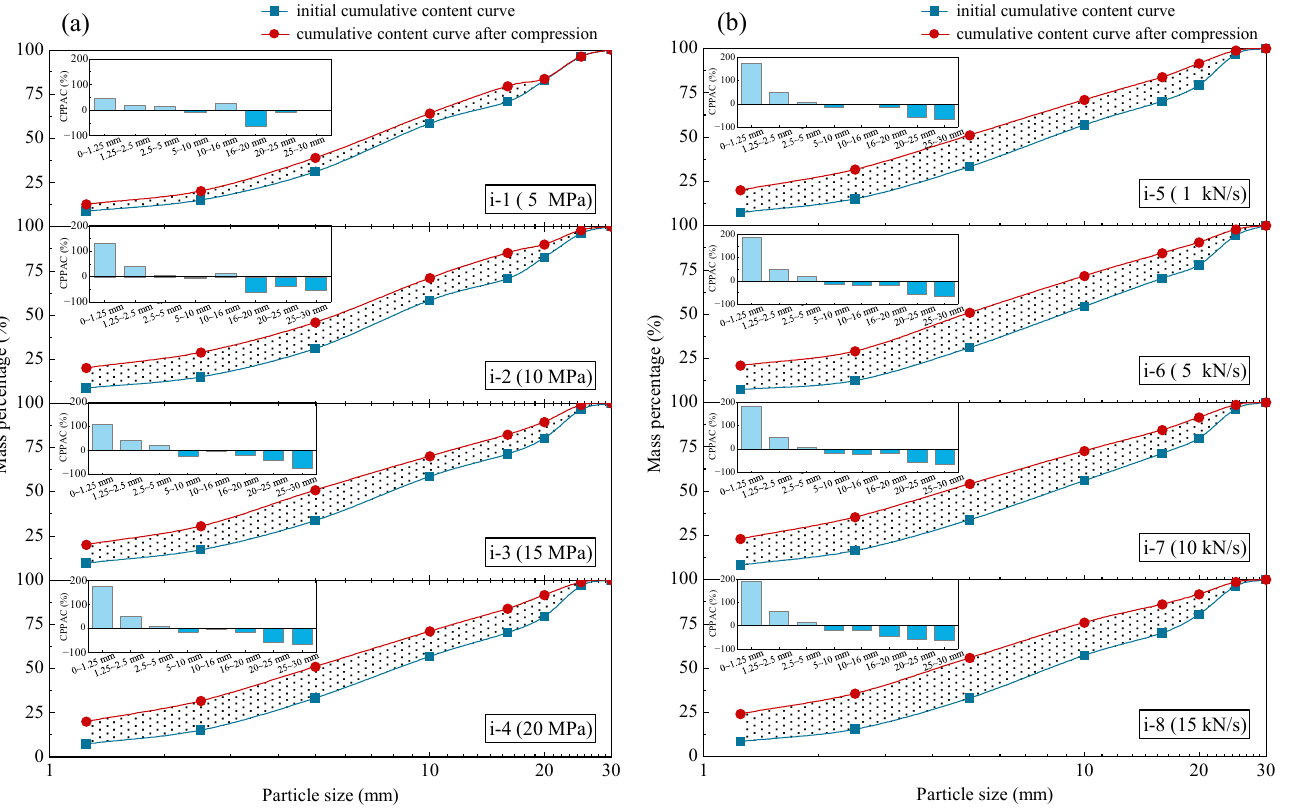
Figure 6. Mass percentage change in particles in different size grades before and after compression graph. CPPAC is the change of particle percentage after compression. If n is the initial mass of the particles in a particular size grade before compression, and m is the mass of the particles in such size grade after compression, then CPPAC = (m − n)/n × 100%. ( a ) is a graph for specimens i-1 to i-4; ( b ) is a graph for specimens i-5 to i-8. Figure 6a highlights the significant effects of loading stress on particle breakage.